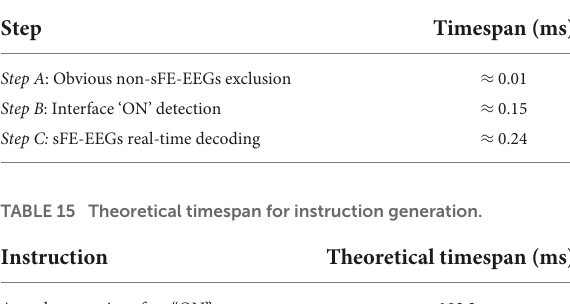
paradigm system. The final deviation of the wooden block